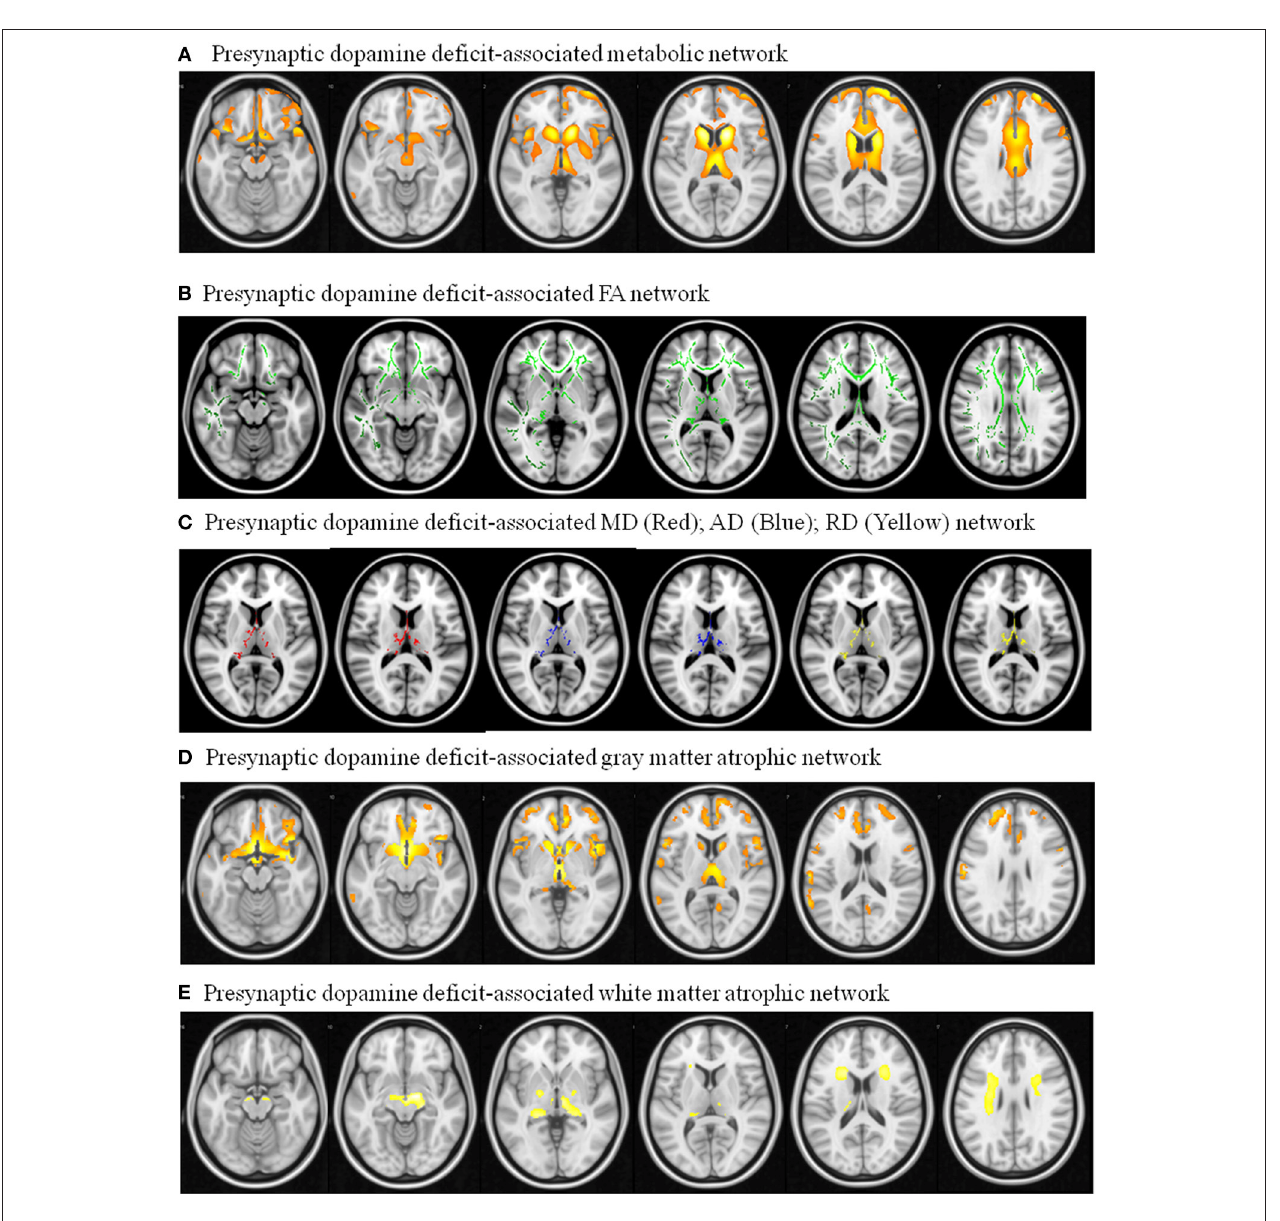
FIGURE 5 | Pre-synaptic dopaminergic deficit-associated network with dependent variable using (A) 18 F-fluro-2-deoxyglucose positron emission tomography ; (B) Fractional anisotropy (FA); (C) mean diffusivity (MD), axial diffusivity (AD), radial diffusivity (RD); (D) 3D T1-weighted segmented gray matter image; (E) 3D T1-weighted segmented WM image. Image results overlay on the T1 template.